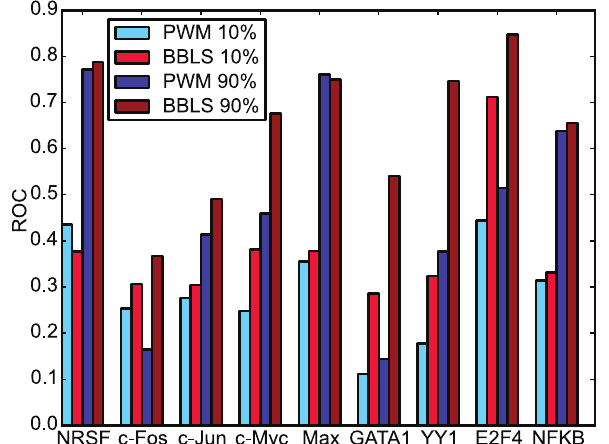
Figure 5. ROC scores for PWM and BBLS PWM on low and high peaks. ROC scores on each TF promoter dataset for PWM and BBLS PWM methods on the lowest peaks ( v 10 percentile), and highest peaks ( w 90 percentile). The difference between PWM and the conservation- based BBLS PWM method is generally greater, and in favor of BBLS PWM, on the higher peaks more than the lower peaks.